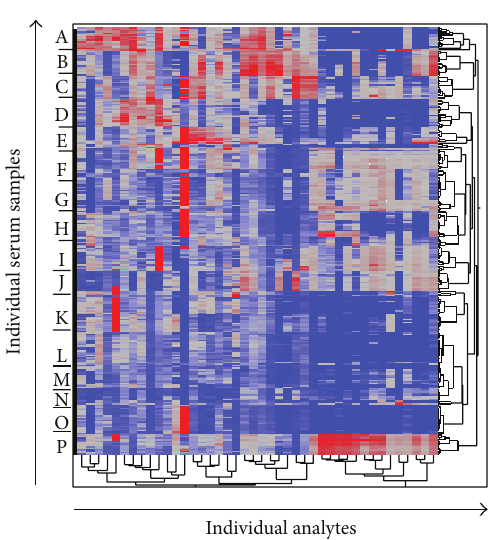
Figure 2: Unsupervised hierarchical clustering of all data. Pro- tein levels of peripheral blood cytokines and growth factors as determined by multiplex cytokine array were log-normalized and clustered.Eachrowrepresentsanindividualserumsample,andeach analyte measured with the multiplex cytokine array is represented by a column. Even with log-transformation, all subjects’ samples exhibited a strong tendency to cluster with other samples from the same subject, giving the impression of distinct subject-specific “bands” (labeled A–P) within the